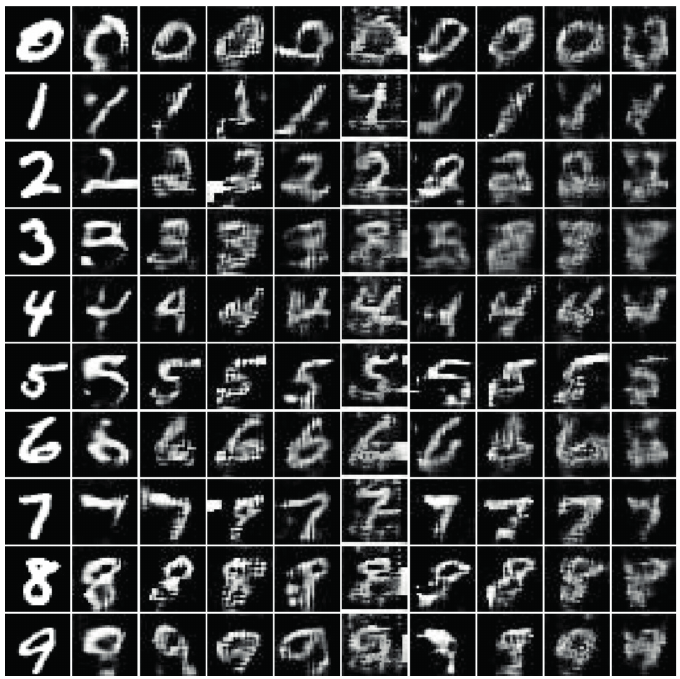
Figure 6. Examples of generated images when different compression rates were used for the vOICe encoding. Each row shows a gradual change of each generated MNIST digit image with the change in compression ratio. The left-most column contains unencoded MNIST digits; the second left-most column contains digits encoded by the vOICe, but not compressed; columns from third left-most to the right contain digits encoded with compression ratios from 10% to 80%, increased by 10%.